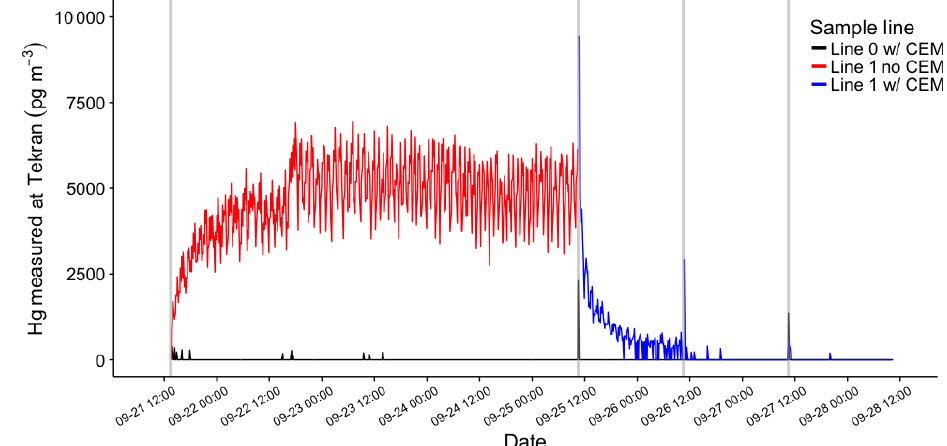
Figure 3. HgBr 2 permeations in clean dry laboratory air using the configuration in Fig. 1b (red line) and Fig. 1c (blue line). The red line indicates total Hg released from permeation tube and passing through the pyrolyzer on Line 1 before being measured by Tekran 2537A. The black line indicates Hg reaching 2537A through CEM filters on Line 0. Vertical grey lines indicate open system during filter